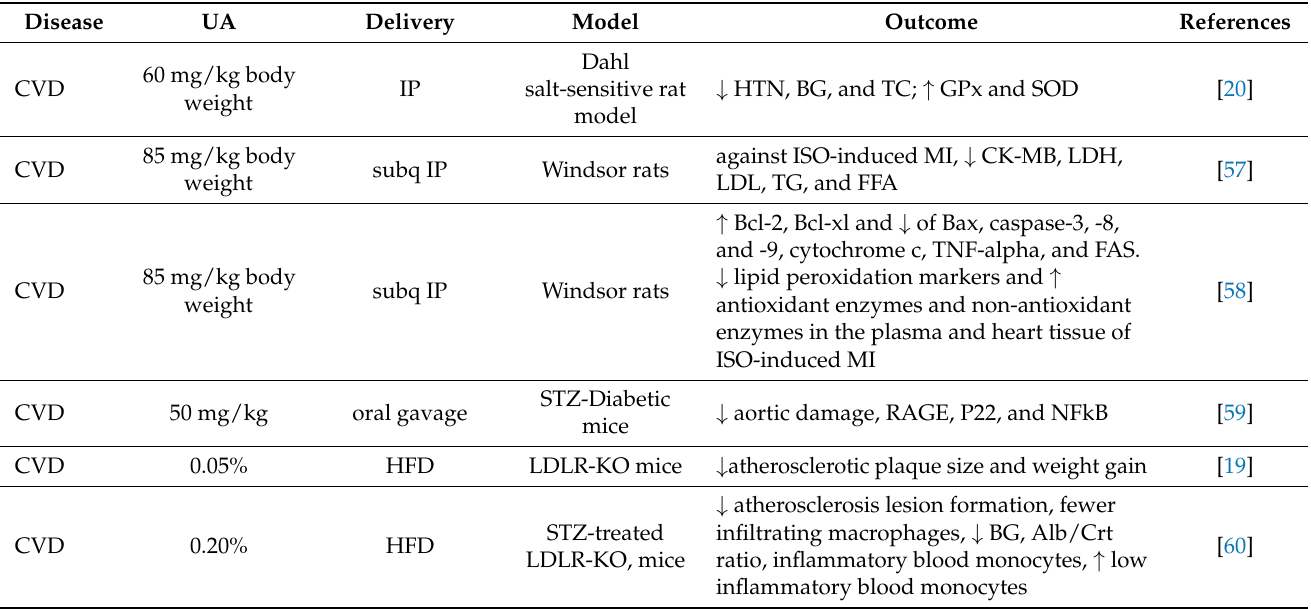
Table 1. UA in animal disease